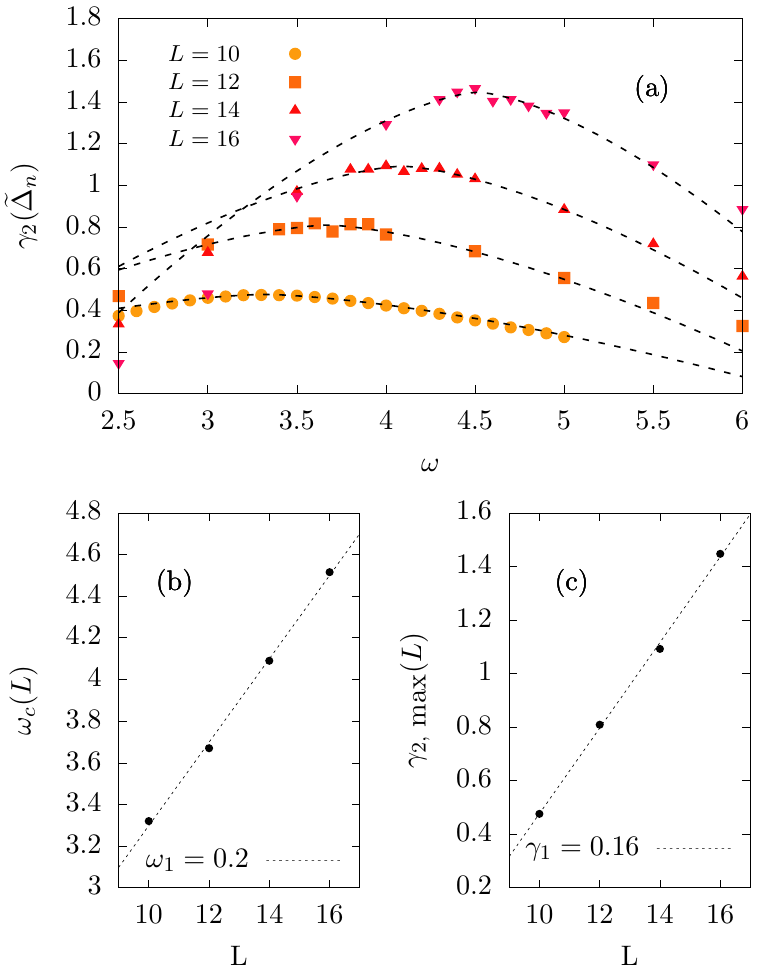
( ∆ ) , Eq. (7), as a function of the disorder strength Figure 3: (a) Kurtosis excess, γ (cid:101) n 2 ω for the number of sites L ∈ { 10,12,14,16 } . The dashed line shows the fit to ( L ) , as a function of the system size, L . The dotted Eq. 8. (b) Critical value, ω c ( L ) = ω + ω L . (c) Maximum of the kurtosis line displays the best linear fit, ω c 0 1 ( L ) , as a function of L . Again, the dotted line displays the best linear excess, γ 2,max ( L ) = γ + γ L fit, γ 2,max 0 1